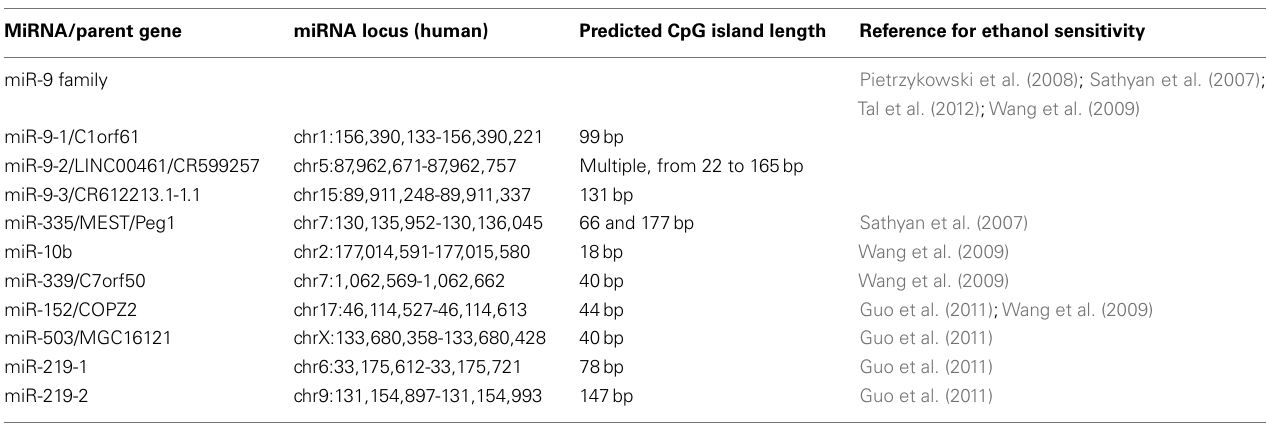
Table 1 | Methylation-sensitive ethanol miRNAs MiRNA/parent gene miRNA locus